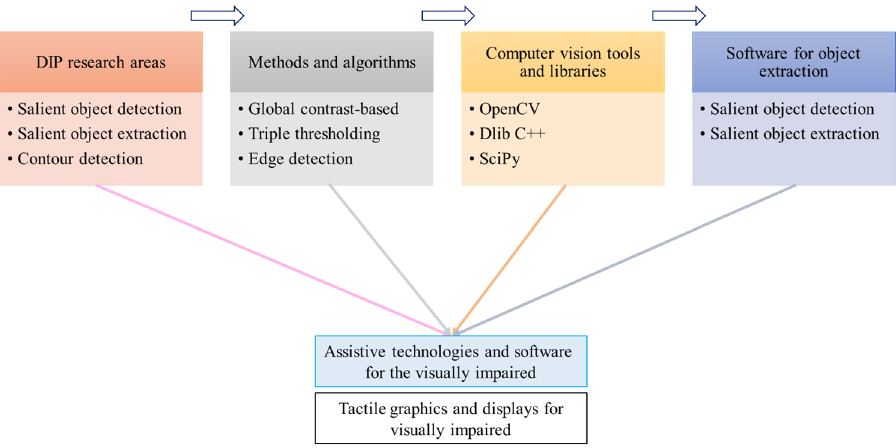
Figure 2. The methodology of research work.